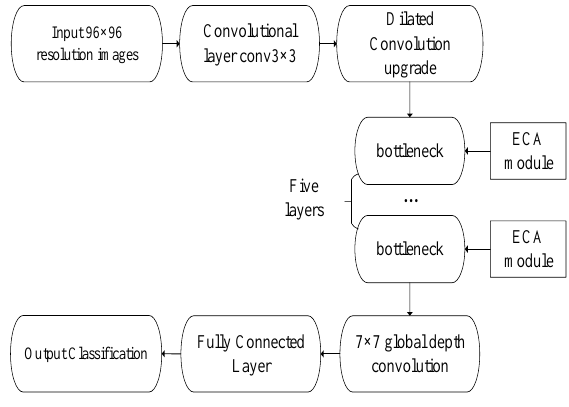
Figure 4. Face image processing. (a) Detected face (b) 112 × 112 ， (c) 96 × 96